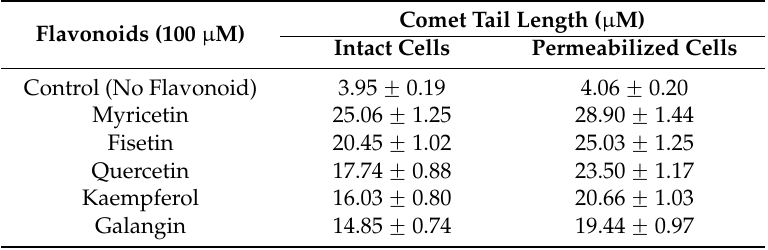
Table 1. A comparison of DNA breakage induced by various flavonoids in intact lymphocytes and permeabilized lymphocytes as a function of comet tail lengths. Values reported are ±SEM of three independent experiments. p < 0.01 by comparison with control (untreated cells) for each compound.